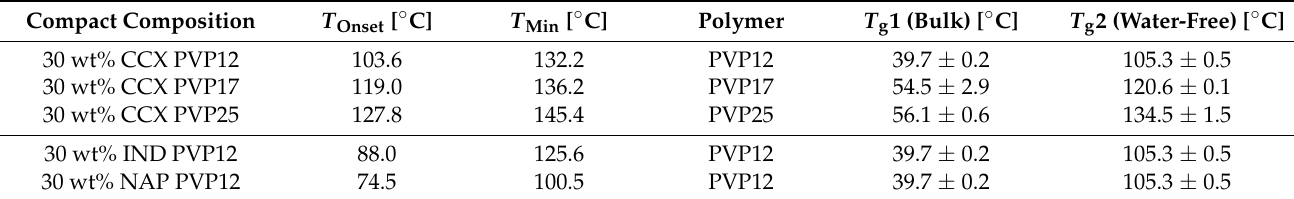
Table 1. The determination of the compact temperature thresholds, i.e., T Onset and T Min , i.e., the temperatures where the in situ amorphization starts and is completed, respectively. T g 1 is the T g of the bulk polymer containing water. T g 2 is the T g of the water-free polymer. T g 1 and T g 2 are given as the Mean ± SD ( n = 2). Compact